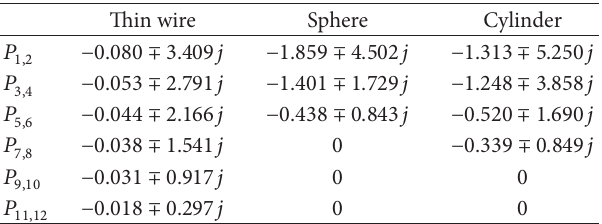
program that does the relevant calculations in the frequency domain and an IFFT algorithm that transforms the data to the time domain. The number of frequency samples is chosen to be at 256.